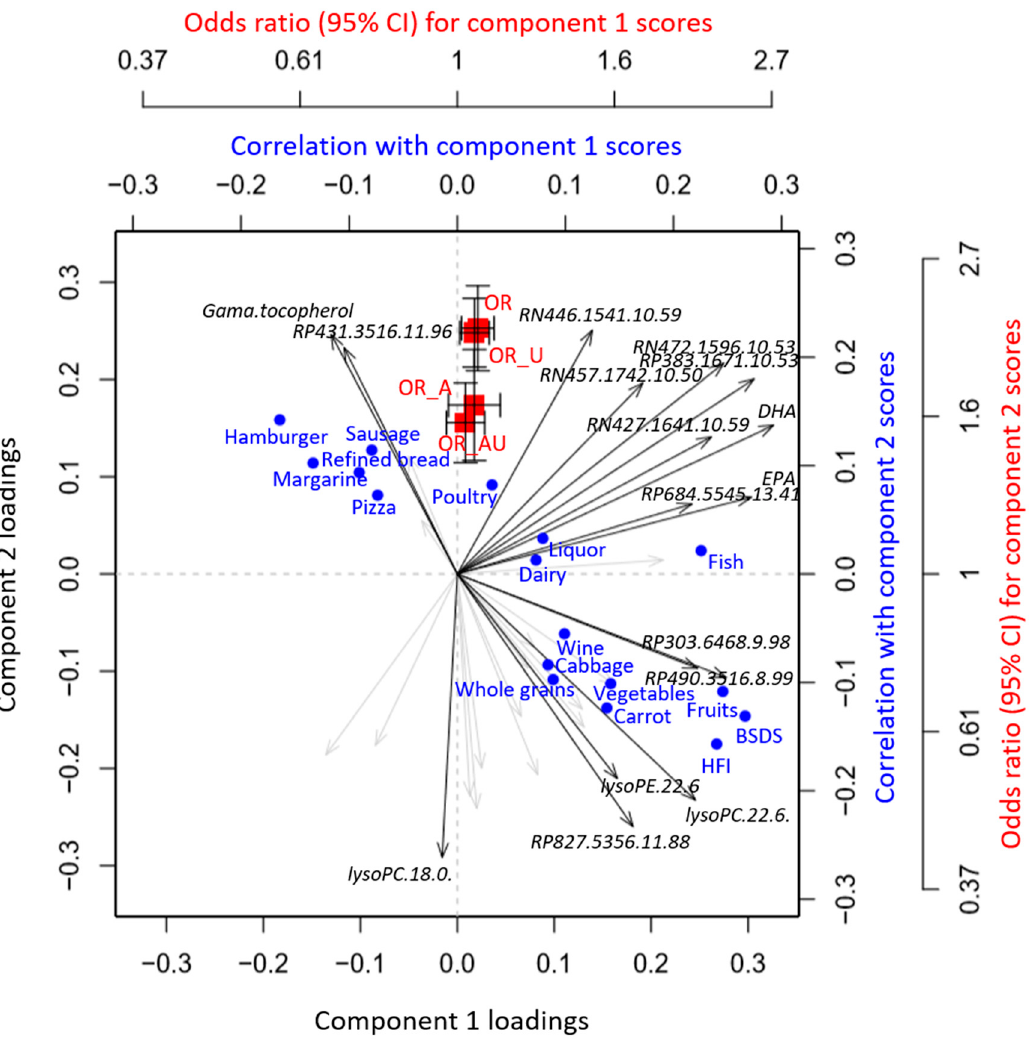
Figure 3. A PCA-based triplot visualizing the inter-correlation between plasma metabolites related to healthy Nordic diet and dietary intake variables as well as association with type 2 diabetes (T2D) risk. Odds ratios of T2D were calculated using conditional logistic regression with or without adjusting for BMI and lifestyle-related confounders (smoking status, education, physical activity, and total energy intake) (OR_A and OR, respectively). Risk associations were calculated similarly using unconditional logistic regression (OR_AU and OR_U, respectively). Correlations between PCA components and dietary intakes were calculated using partial Pearson method, adjusted for case-controlled status, gender, age, BMI, and lifestyle-related confounders (smoking status, education, and physical activity). Only metabolite feature loadings > 0.25 and dietary intake variables significantly correlated with the PCA components are shown.